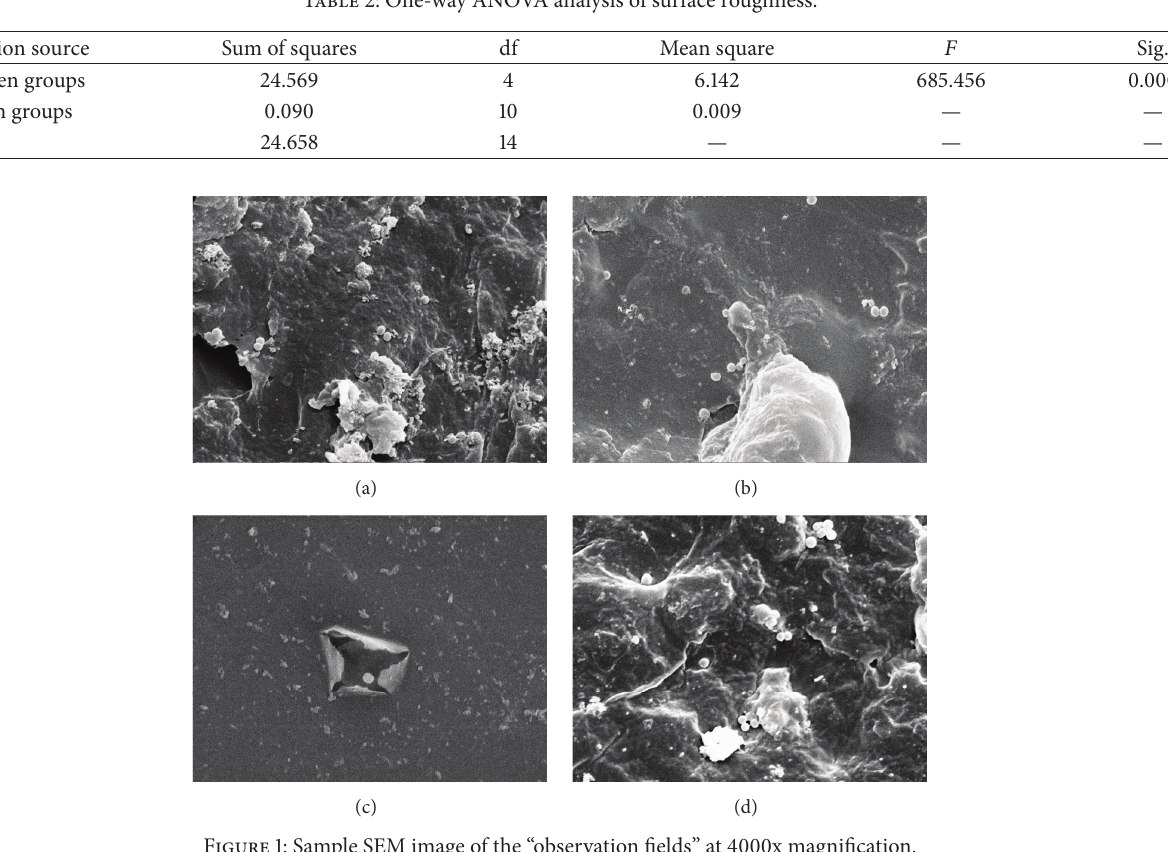
Figure 1: Sample SEM image of the “observation fields” at 4000x magnification.